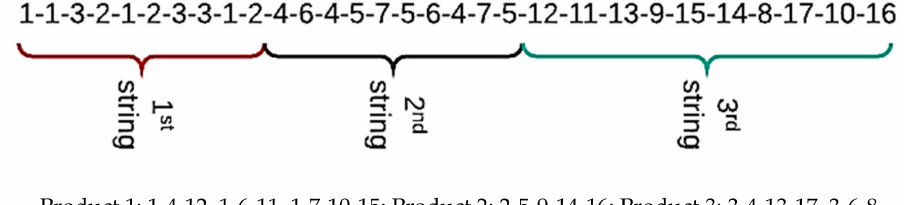
Figure 5. Solution representation.